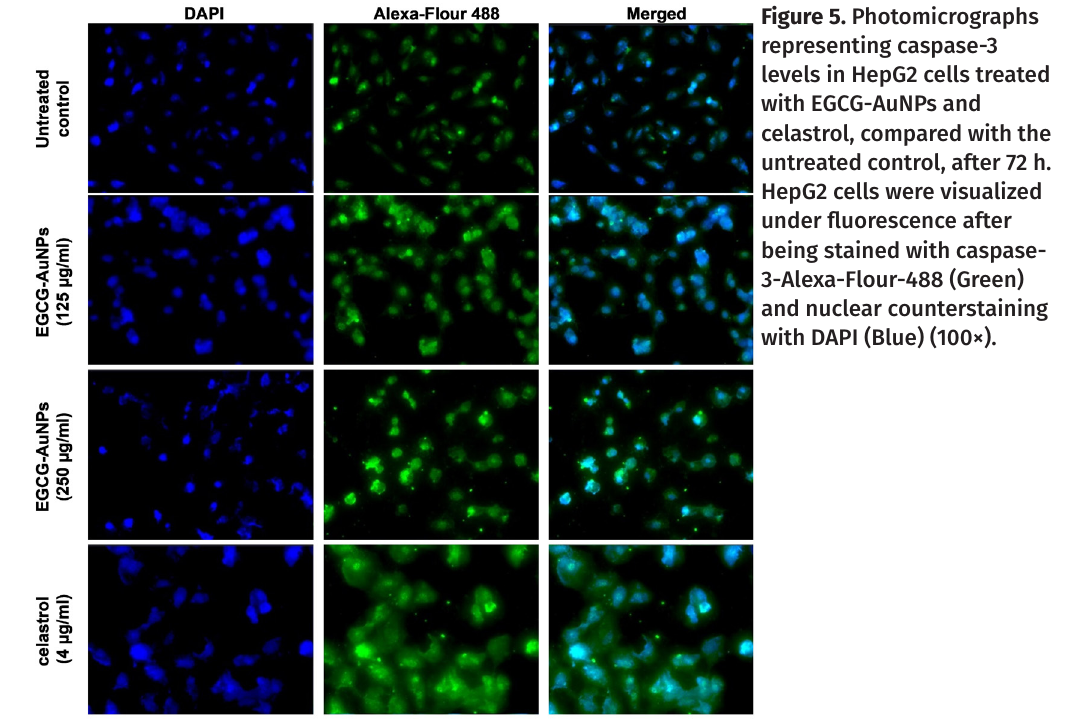
Figure 5. Photomicrographs representing caspase-3 levels in HepG2 cells treated with EGCG-AuNPs and celastrol, compared with the untreated control, after 72 h. HepG2 cells were visualized under fluorescence after being stained with caspase- 3-Alexa-Flour-488 (Green) and nuclear counterstaining with DAPI (Blue)